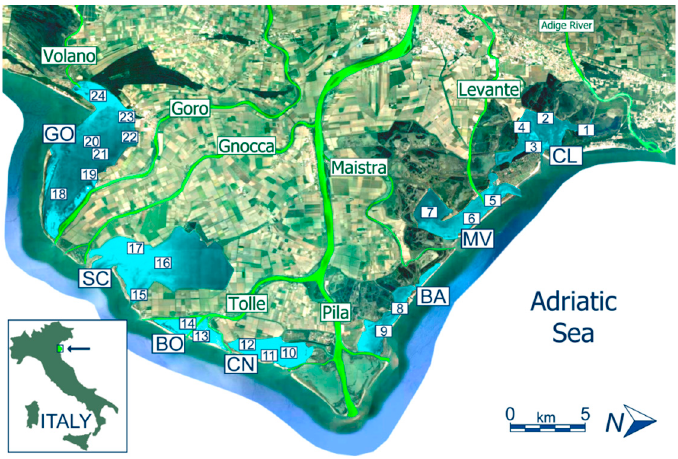
Figure 1. Map of the Po Delta, along with names of distributaries. Sampling sites are labelled with two capital letters identifying the lagoon and core numbers from 1 to 24: CL = Caleri, MV = Marinetta-Vallona, BA = Barbamarco, CN = Canarin, BO = Bonelli, SC = Scardovari, GO = Goro.